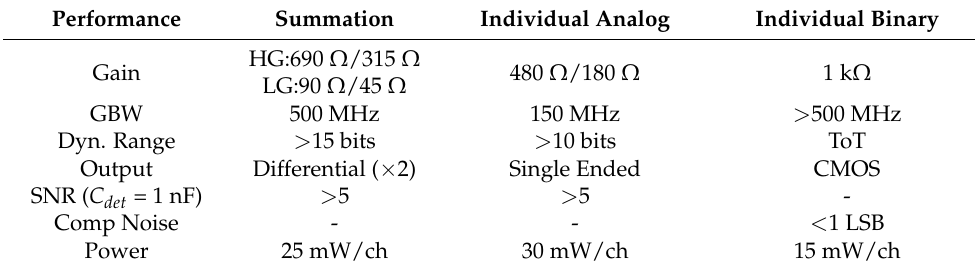
Table 1. Performances of the different functional modes. Note that the comparator noise is expressed in LSBs (1.58